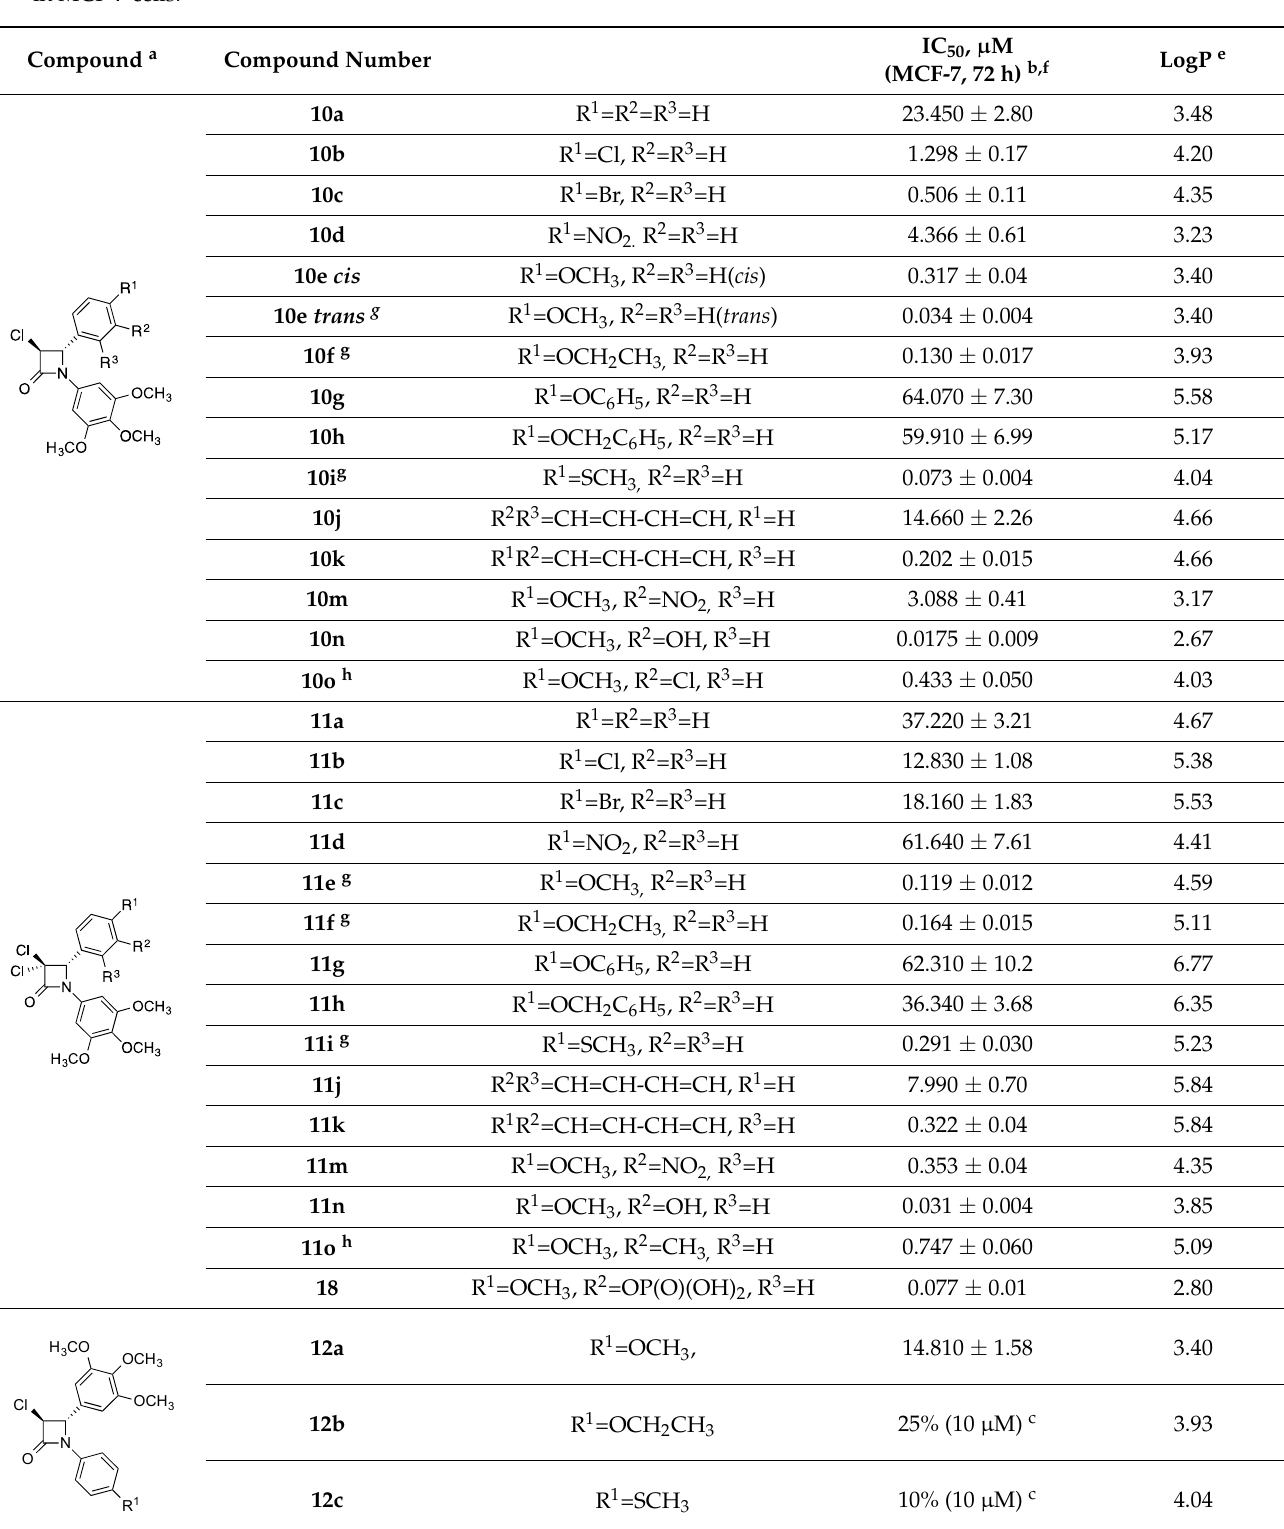
Table 3. Antiproliferative activity of β -lactam compounds 10a – o , 11a – o , 12a – c , 13a – c , 14a , 14b , 15a , 15b , 16a – j , 18 and CA-4 in MCF-7 cells.